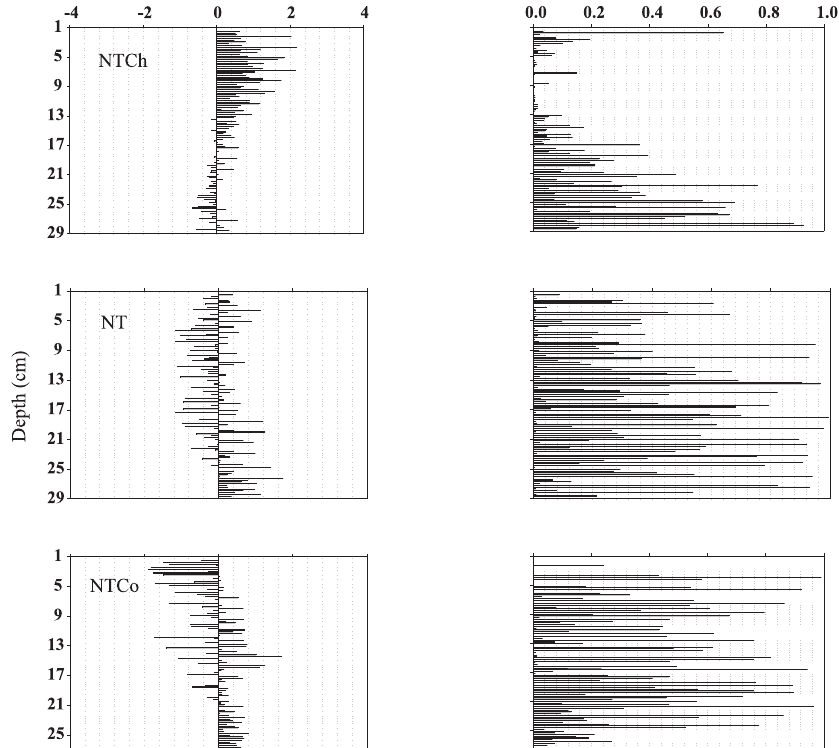
Figure 2. Indicators of normal distribution of penetration resistance at different compaction levels and in soil layers. NTCh: no-tillage with chiseling; NT: no-tillage; NTCo: no-tillage with